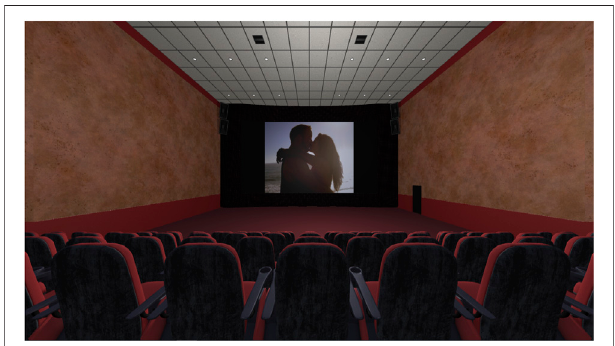
FIGURE 2 | Virtual reality movie theater environment used in the